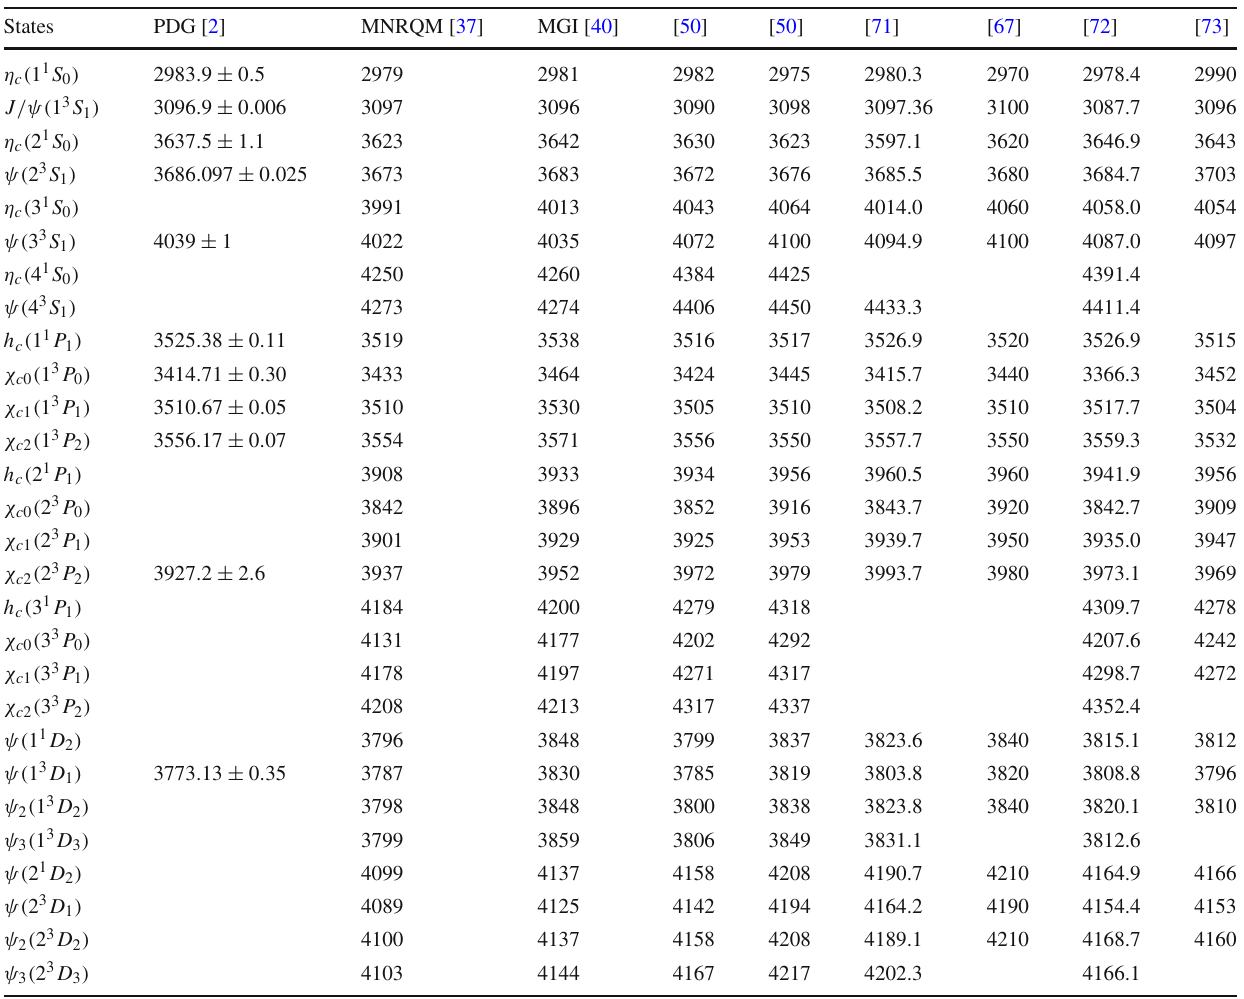
Table 4 The mass spectra (in MeV) of charmonium states obtained within the modified non-relativistic quark model (MNRQM) and the modified Godfrey–Isgur Model (MGI), and the other predictions are also listed in this table